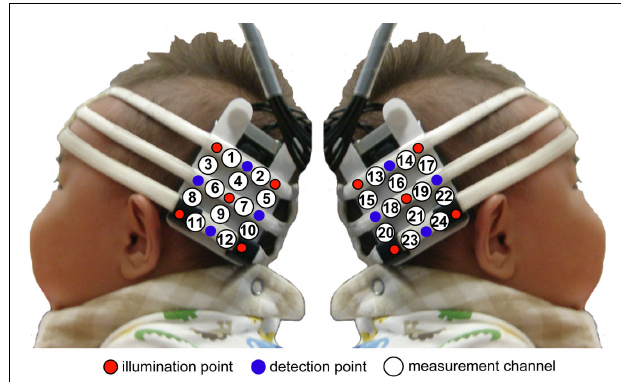
FIGURE 2 | Location of the probe and the measurement channels. The fibers were placed on the left and right temporal areas centering at theT5 andT6 of the International 10–20 system.The distance between the fibers was set at